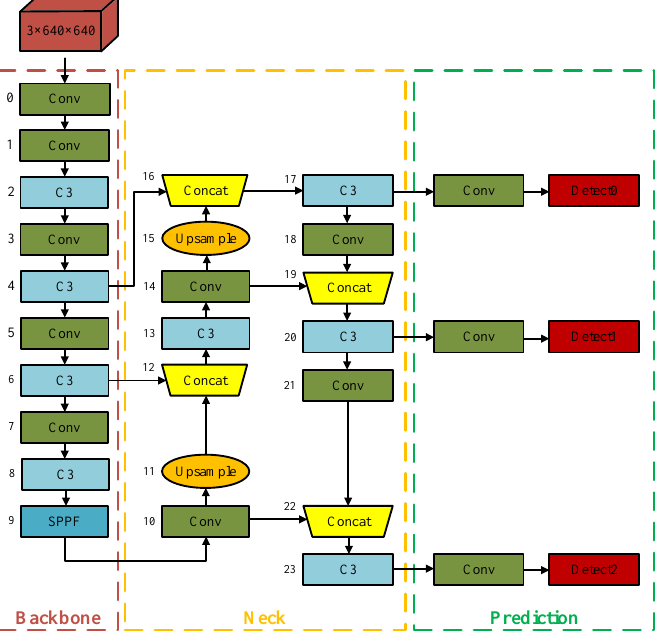
Figure 1. The architecture of YOLOV5.